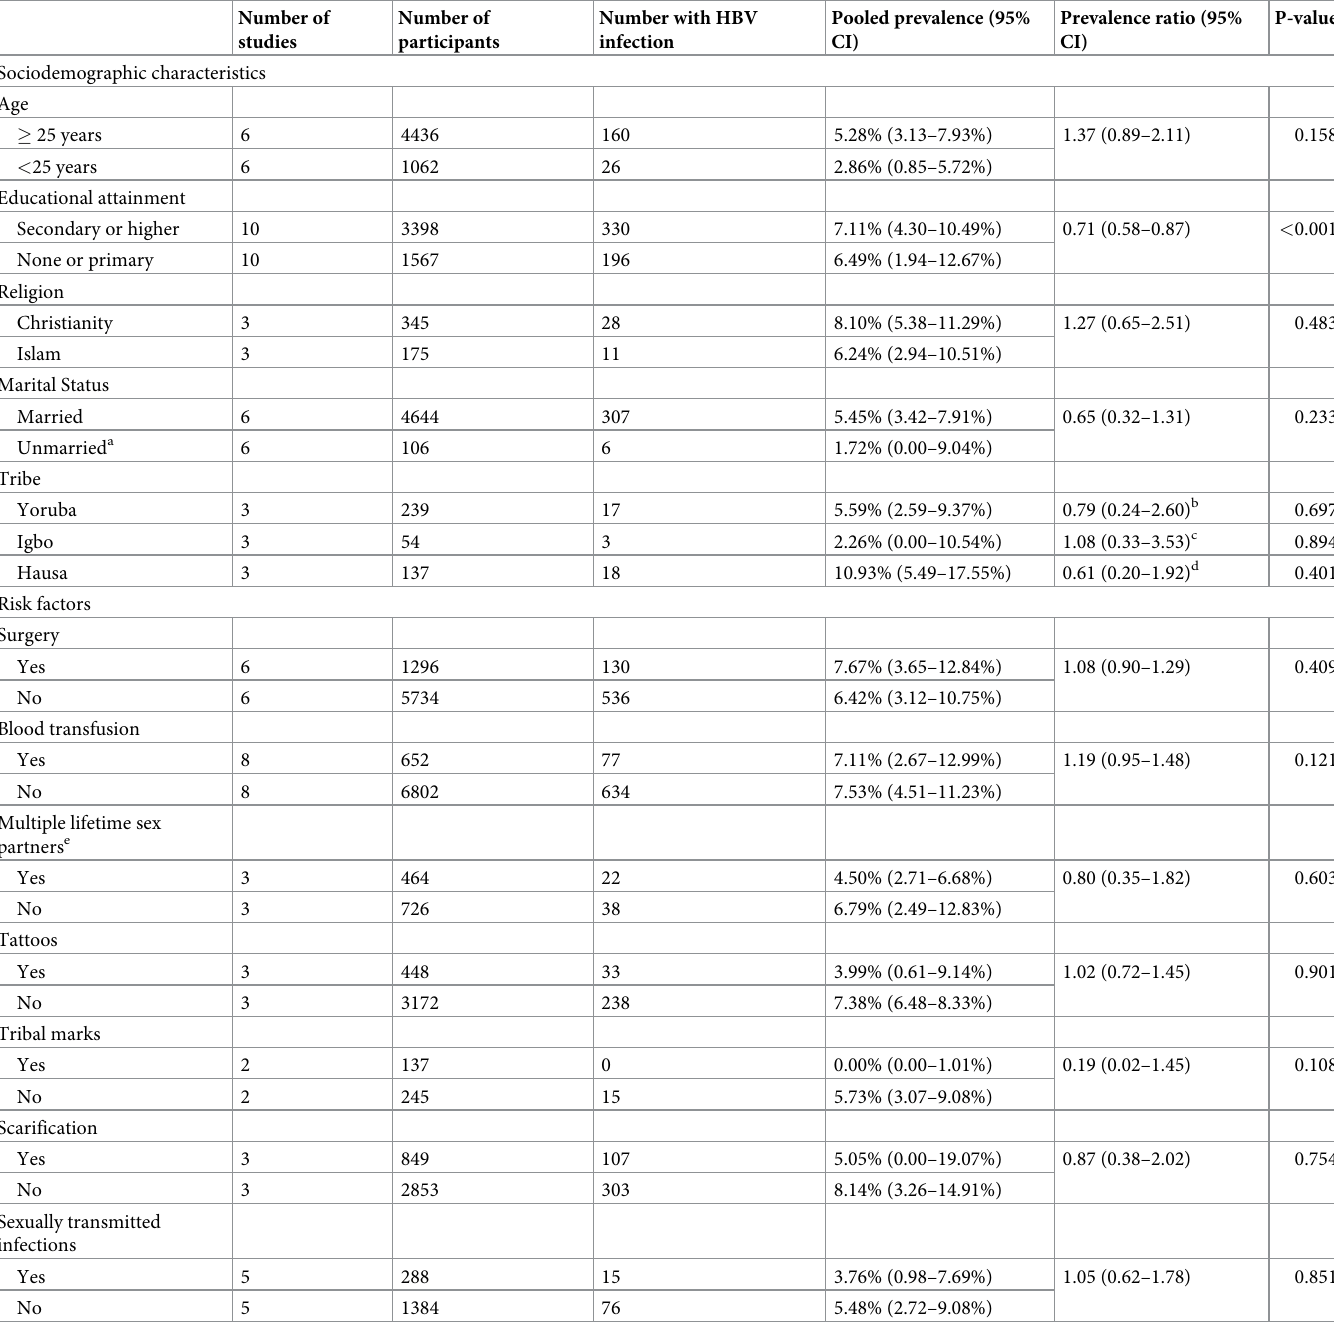
Table 2. HBV prevalence and prevalence ratios among pregnant women in Nigeria by sociodemographic characteristics and known risk factors,